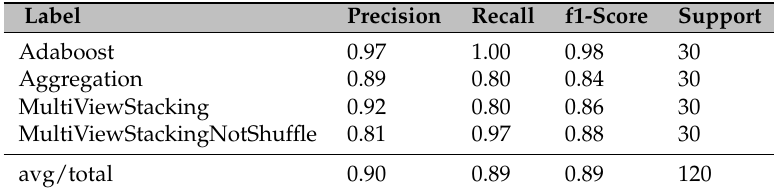
Table 8. Metrics of Multi-view stacking with RFC on the Fingerprint Dataset. Label Precision Recall f1-Score